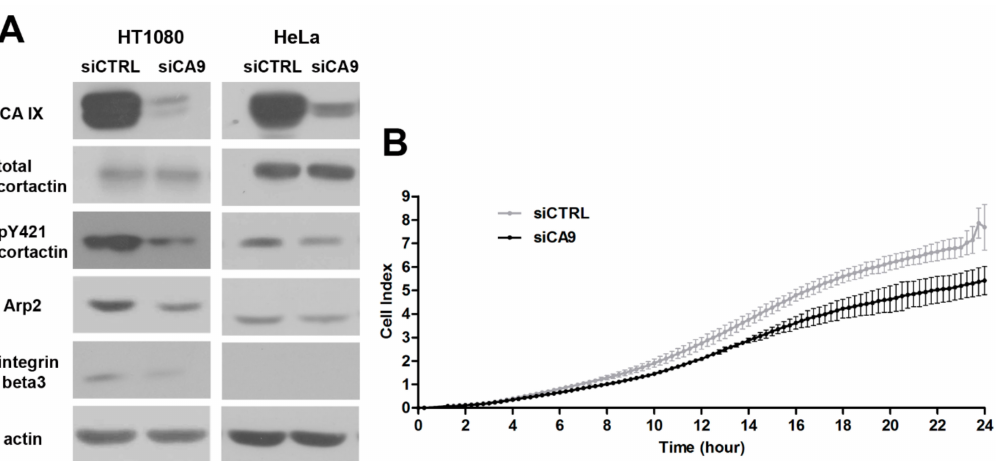
Figure 4. CA9 silencing a ff ects the protein level of invadopodia-associated molecules and influences cancer cell invasion ( A ) Representative Western blot analysis of hypoxia pre-incubated HT1080 and HeLa cells transiently silenced by siCA9. Cells were seeded on gelatin and cultured in 2% hypoxia for further 24 h. CA9 silencing led to reduced protein levels of Arp2 and a phosphorylated form of cortactin in both cell lines. Total level of cortactin remained unchanged. In HT1080, CA9 downregulation also resulted in a decreased level of integrin beta3. This type of integrin was not detected in HeLa. Arp2 and integrin beta3 are involved in invadopodia formation; phosphorylation of Y421 at cortactin is essential for maturation of invadopodia precursors. ( B ) Invasion ability of hypoxia pre-incubated HT1080 cells expressing CAIX and with CA9 silenced was assessed using real-time measurement by xCELLigence device. Cells were seeded in a collagen-coated Boyden chamber, under HGF treatment, and stimulated into invasion toward a chemoattractant in the lower chamber. CAIX expressing cells invade faster than their counterparts without CAIX as shown by higher cell index values, which reflect the number of cells that penetrated through a collagen layer. The graph shows time dependence of the cell index expressed as mean ± stdev of quadruplicates. The experiment was repeated three